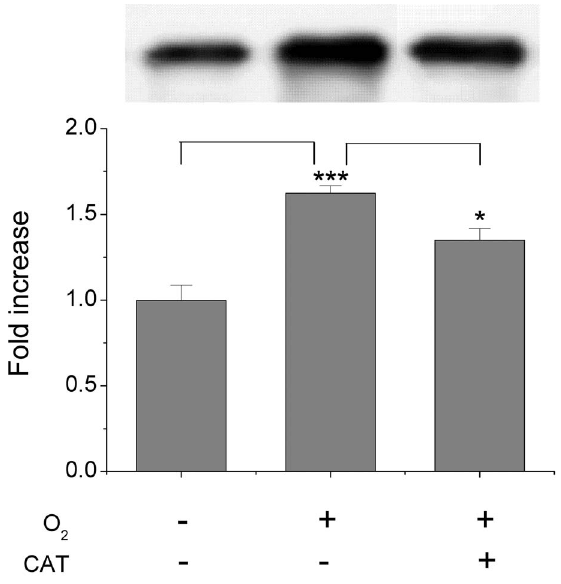
Figure 5. Immunodetection of Gi Prxs in parasitic cells: Effect of O 2 . Western blot analysis of Gi Prxs expression in trophozoites grown for 24 h in anaerobic standard conditions or under air, with or without 120 U mL 2 1 catalase. Densitometric data expressed with reference to the protein levels detected under anaerobic conditions (mean 6 1 SEM, n $ 5). ***P # 0.0002 vs anaerobic conditions. *P # 0.05 vs aerobic conditions w/o